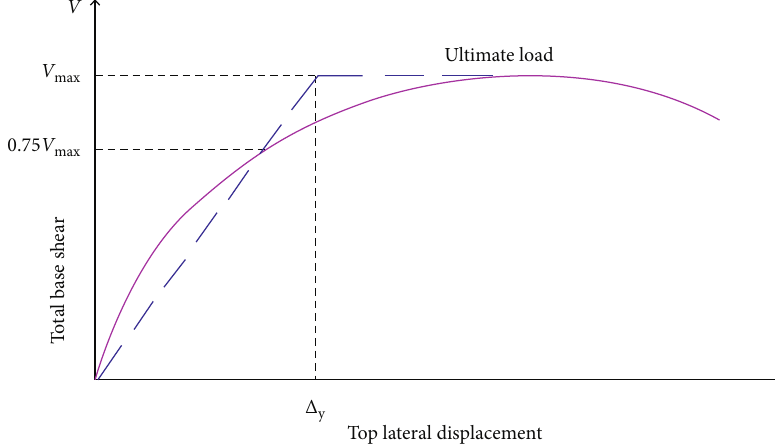
Figure 4: Reduced stiffness method